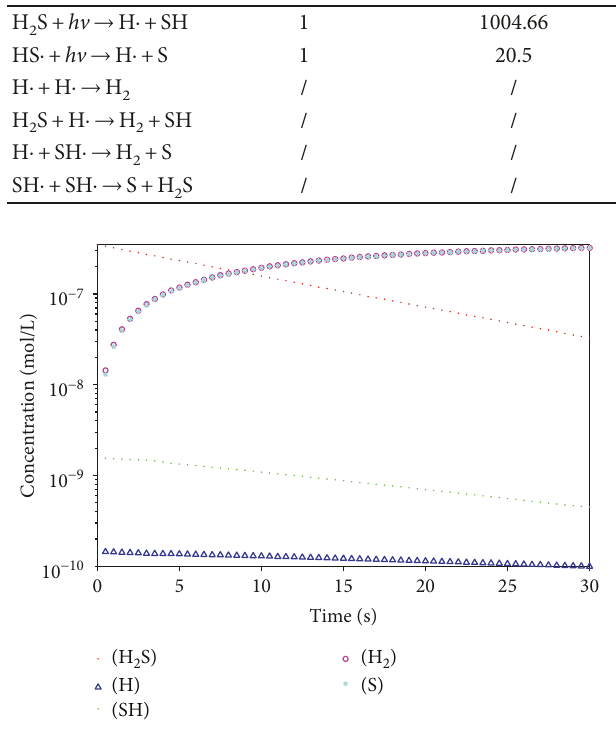
Figure 7: The simulated concentration changes of components of H S photodegradation by UV without the presence of 2